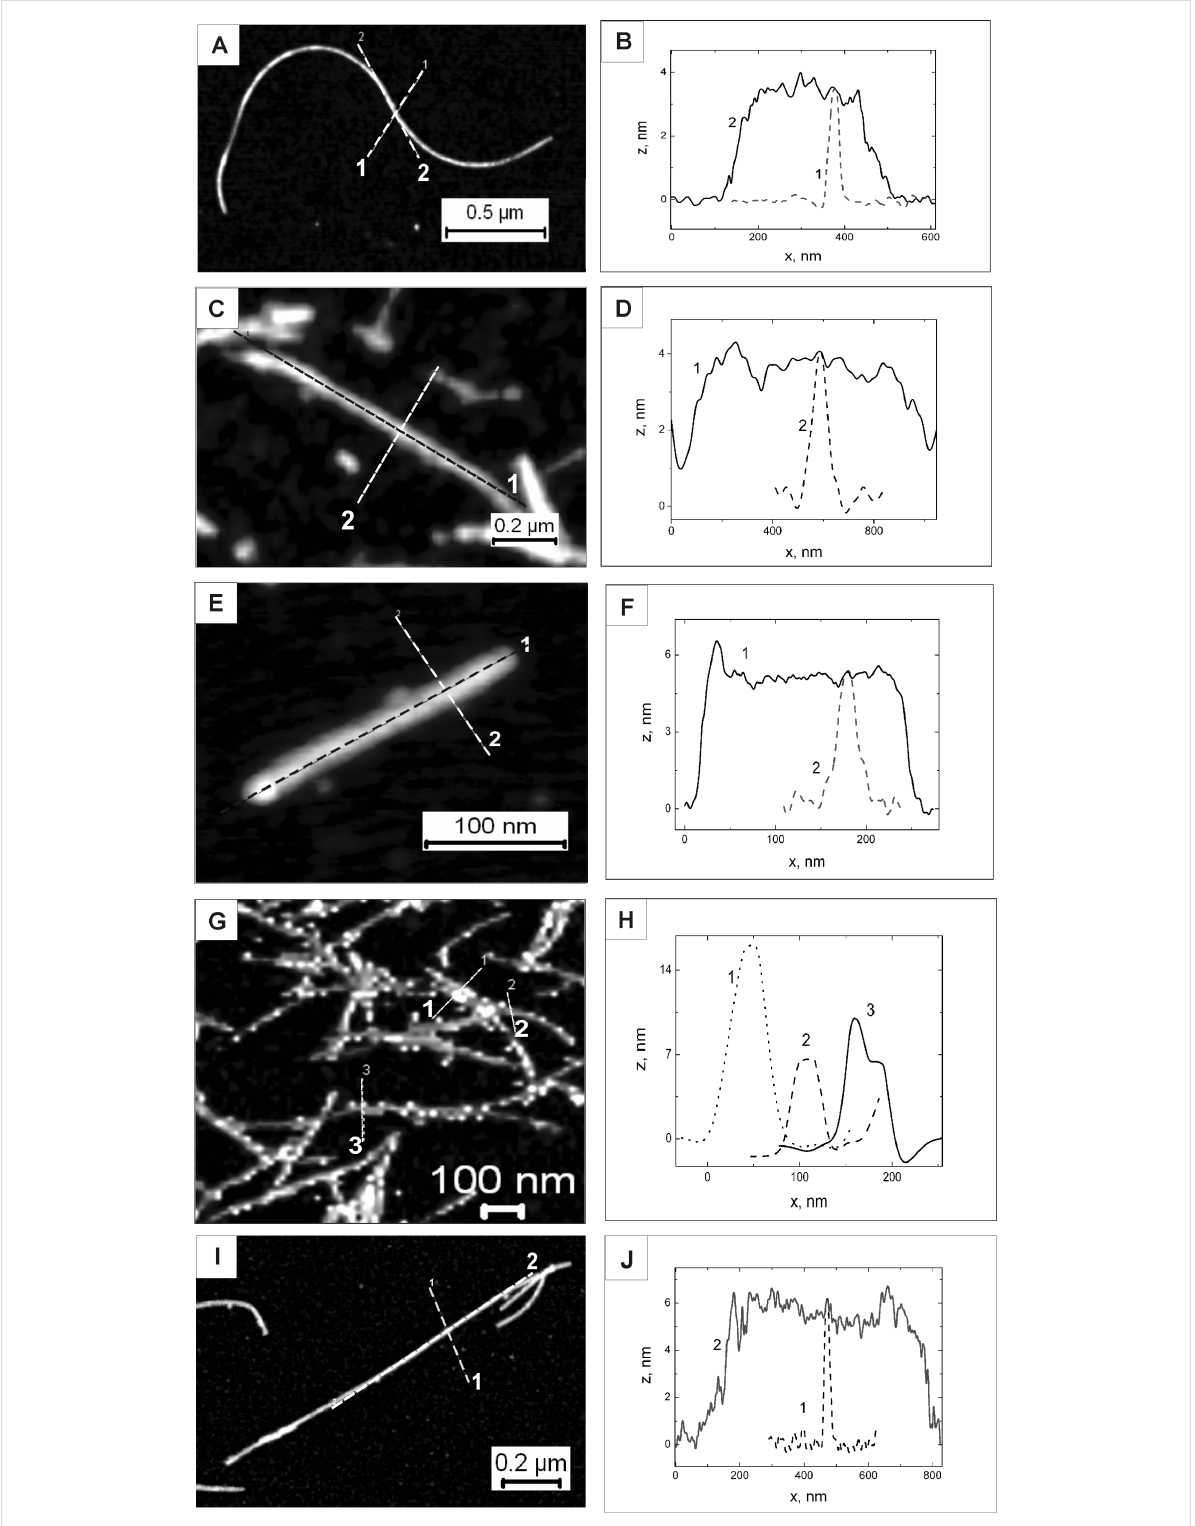
Figure 2: AFM topography images with cross-sectional and axial profiles. α -SynC141 fibril (A and B), fibrils reduced with tris(2-carboxyethyl)phos- phine (TCEP) (C and D), biotinylated α -SynC141 fibrils after reduction with TCEP (E and F), biotinylated α -SynC141 fibrils after incubation with neutravidin-conjugated gold nanoparticles (G and H), and α -Syn fibrils (I and J). The dashed lines in the AFM images indicate the location where the cross-sections and axial measurements were